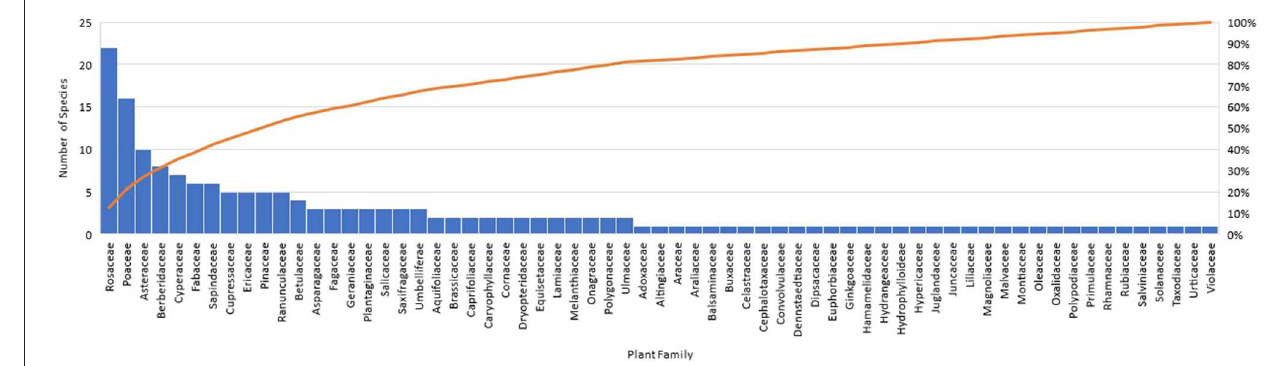
FIGURE 2 | Number of plant species by plant family.